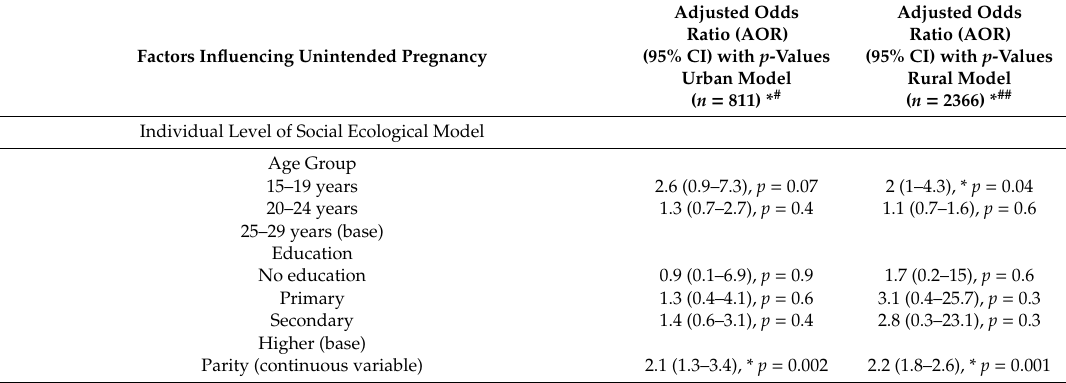
Table 3. Multiple logistic regression analyses showing comparison of adjusted odds ratios (AOR) in urban and rural models (without multiple imputations) for factors influencing unintended pregnancy amongst Cambodian sexually active, single, in union or married females (15–29